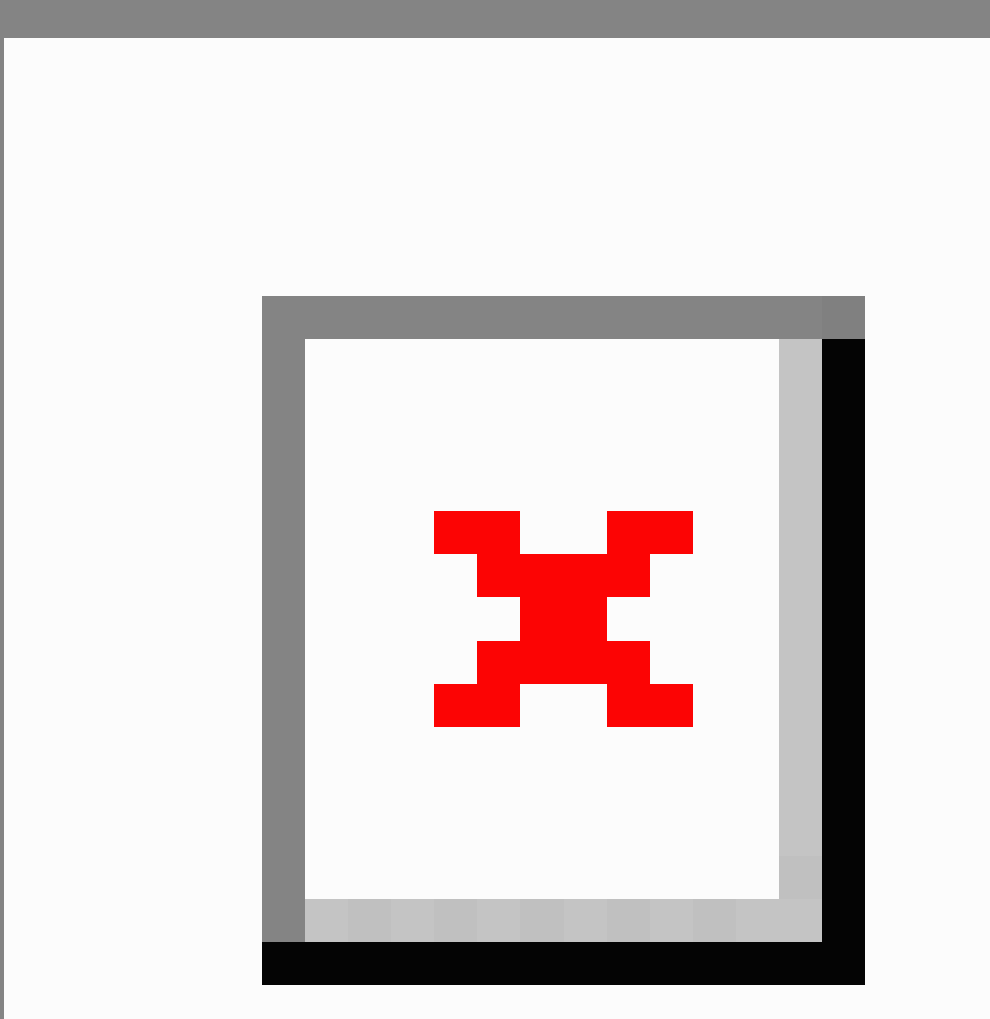
Yu et alJMIR MHEALTH AND